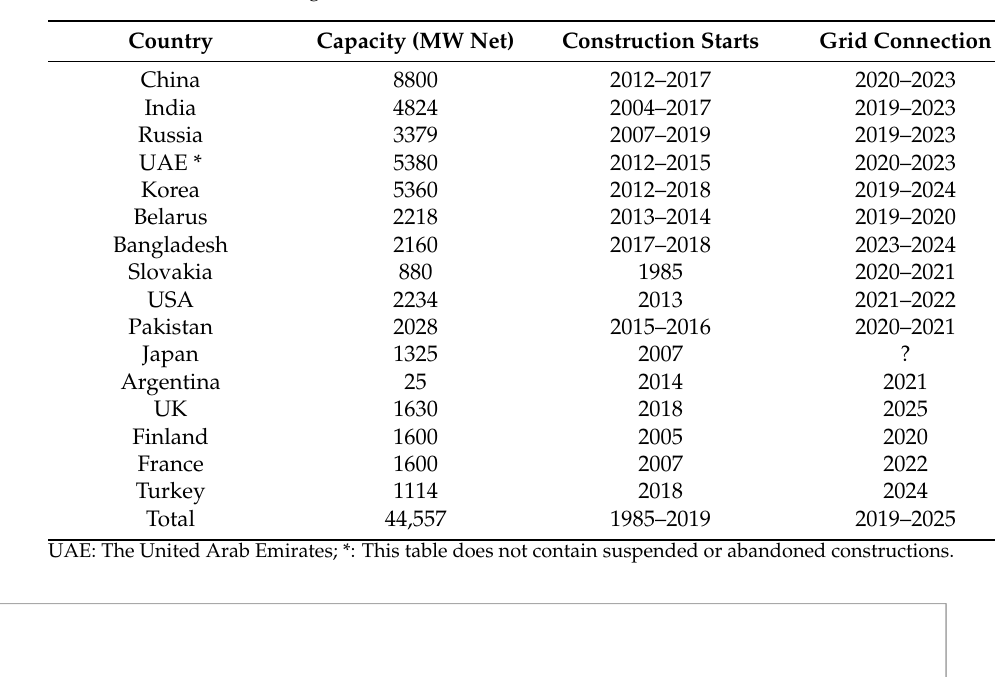
Table 3. Countries building nuclear reactors—as of 2019 [1,38–40].